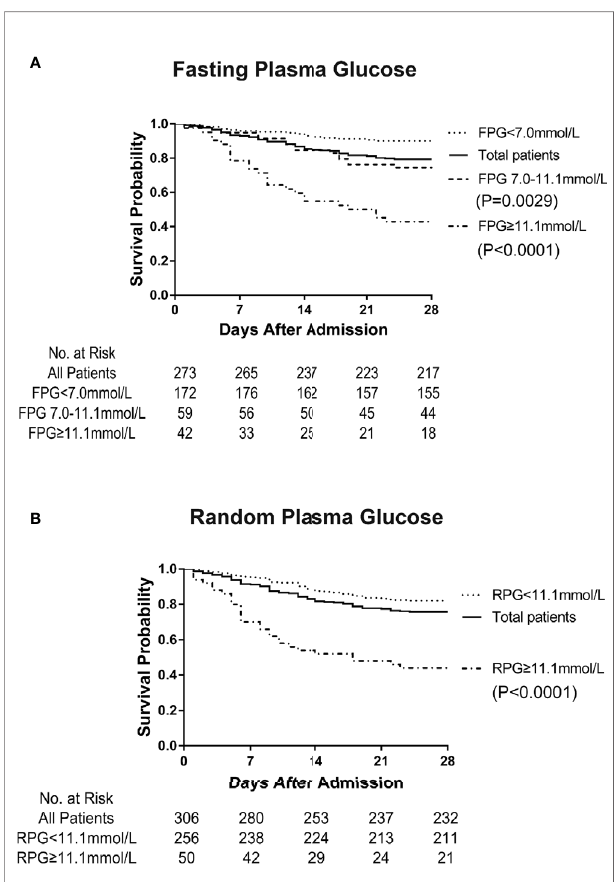
FIGURE 1 | Survival curve of patients with COVID-19 affected by fasting plasma glucose (FPG) and random plasma glucose (RPG) levels on admission. It shows the greatly decreased survival in patients with FPG level ≥ 7.0 mmol/L on admission compared with that in patients with FPG level < 7.0 mmol/L (p < 0.0001) (A) . It indicates the obviously decreased survival in patients with RPG level ≥ 11.1 mmol/L on admission compared with that in patients with RPG level <11.1 mmol/L (p < 0.0001) (B)